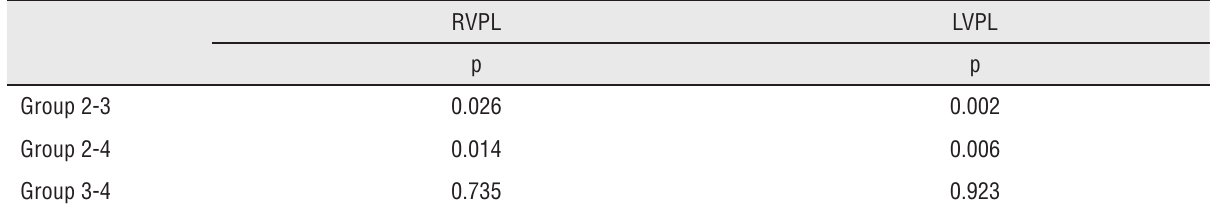
Table 3 - Epv comparative analyses of the groups at the 47 th day.